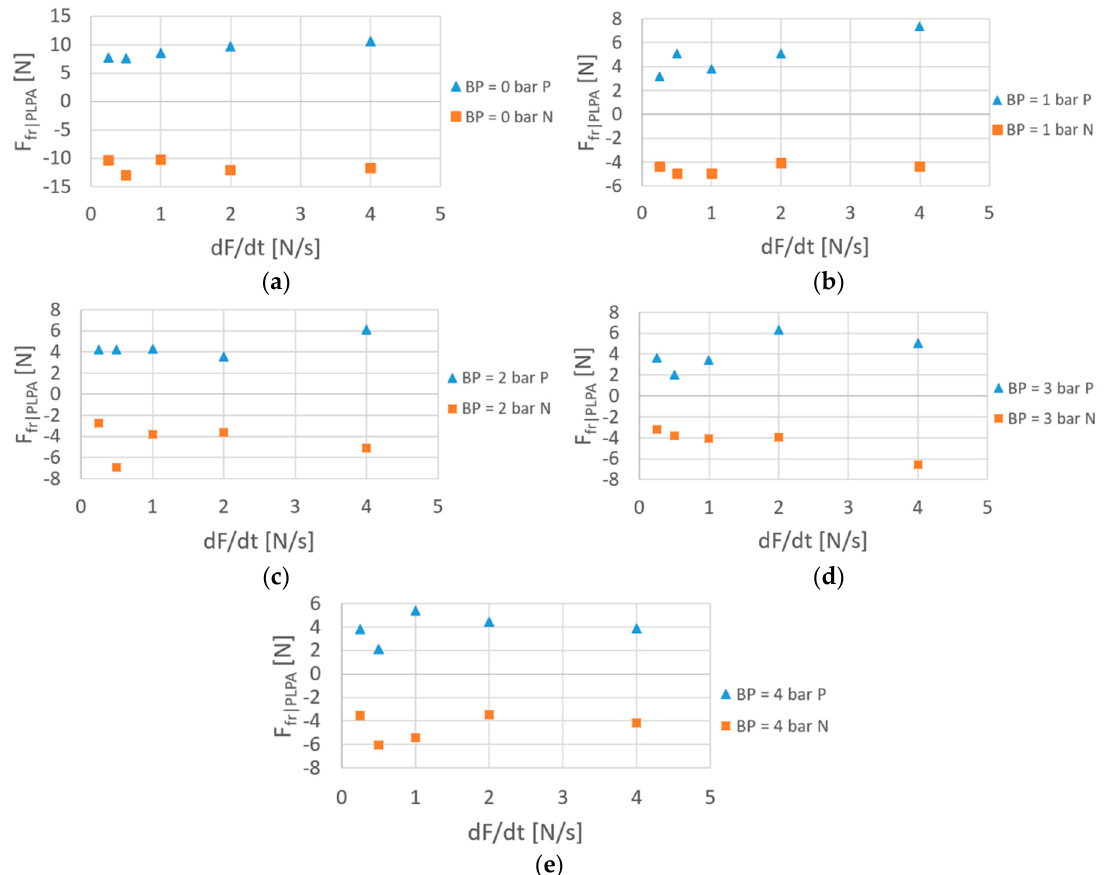
Figure 11. Experimental setup for the static friction force assessment of the PLPA.